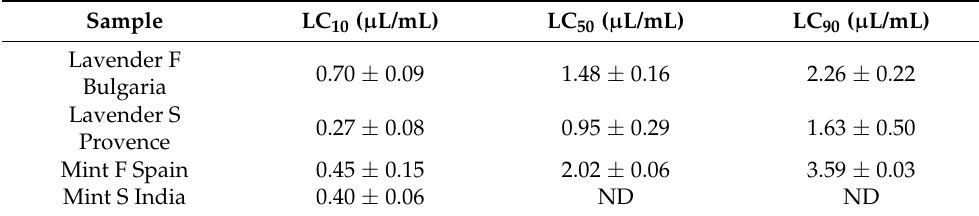
Table 10. Cytotoxicity effect of essential oils on